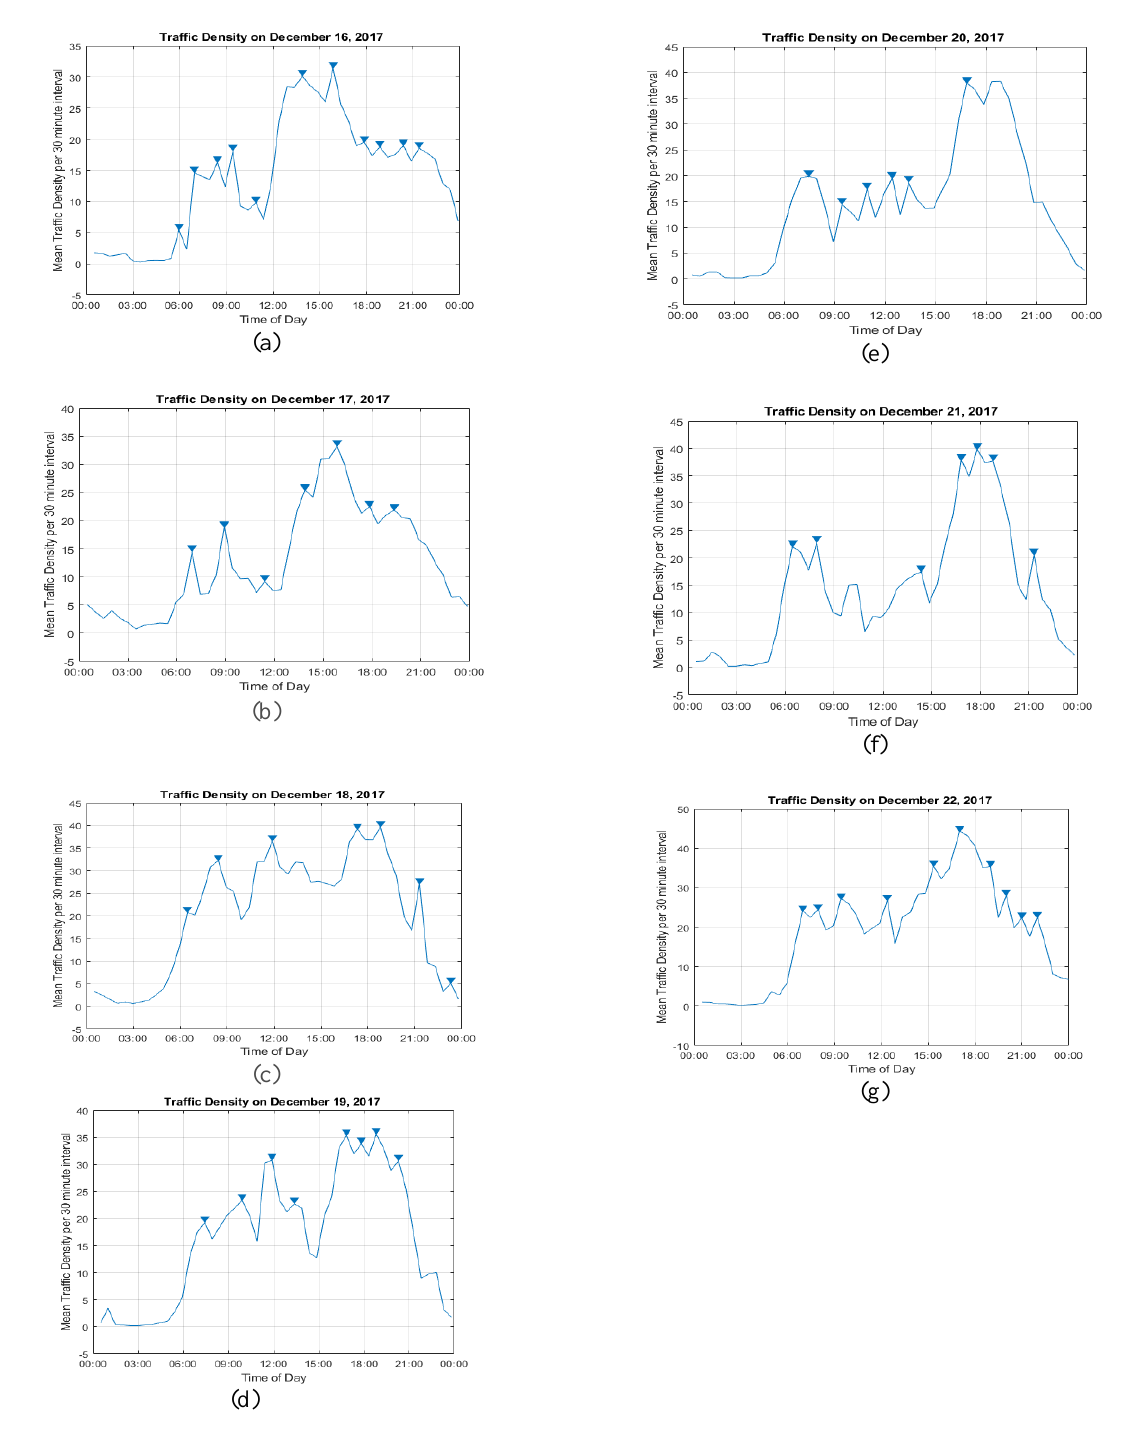
Fig. 9. Traffic Density on day wise- (a). On December 16 (b). On December 17 (c). On December 18 (d). On December 19 (e). On December 20 (f). On December 21 (g). On December